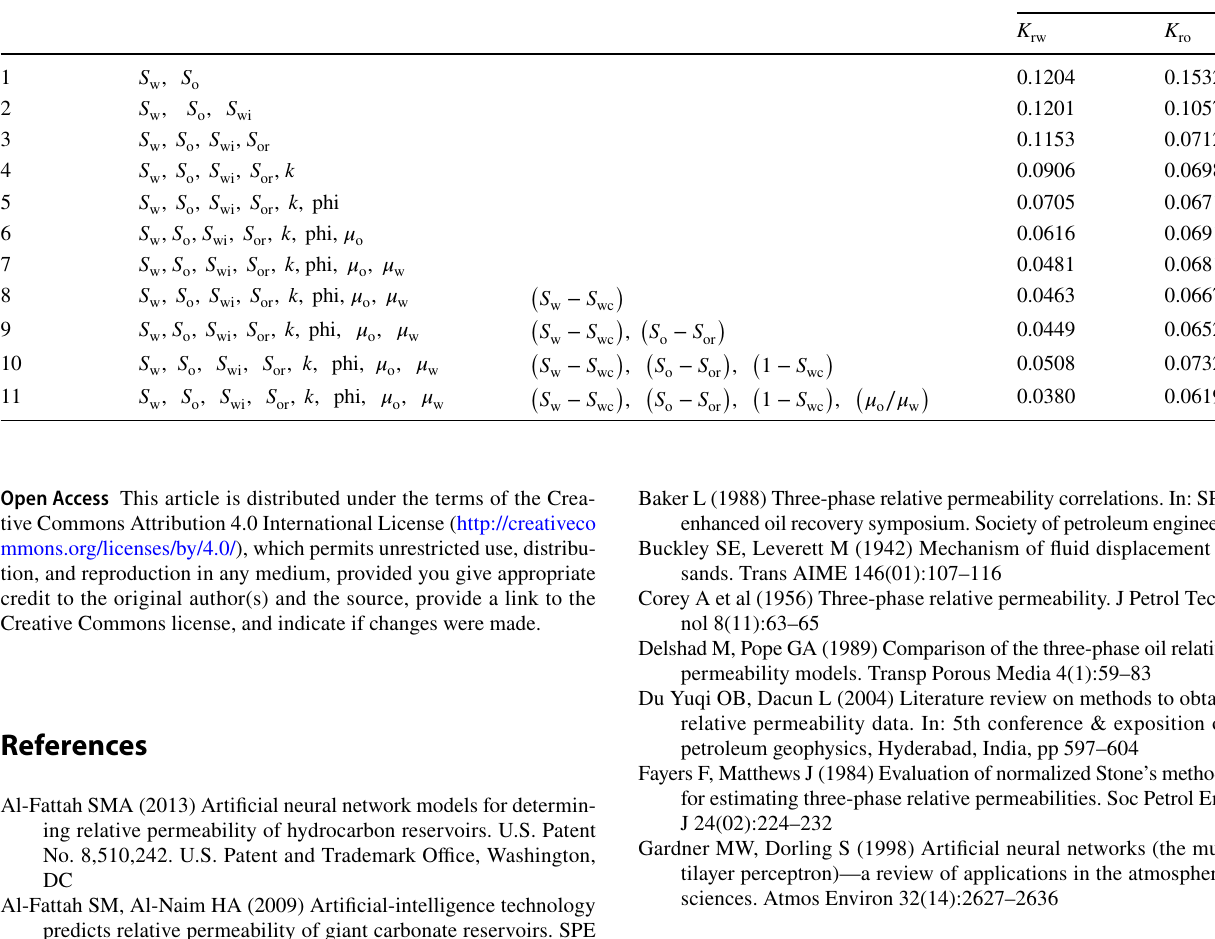
Table 5 Sensitivity analysis showing the importance of the difference to both water and oil relative permeabilities